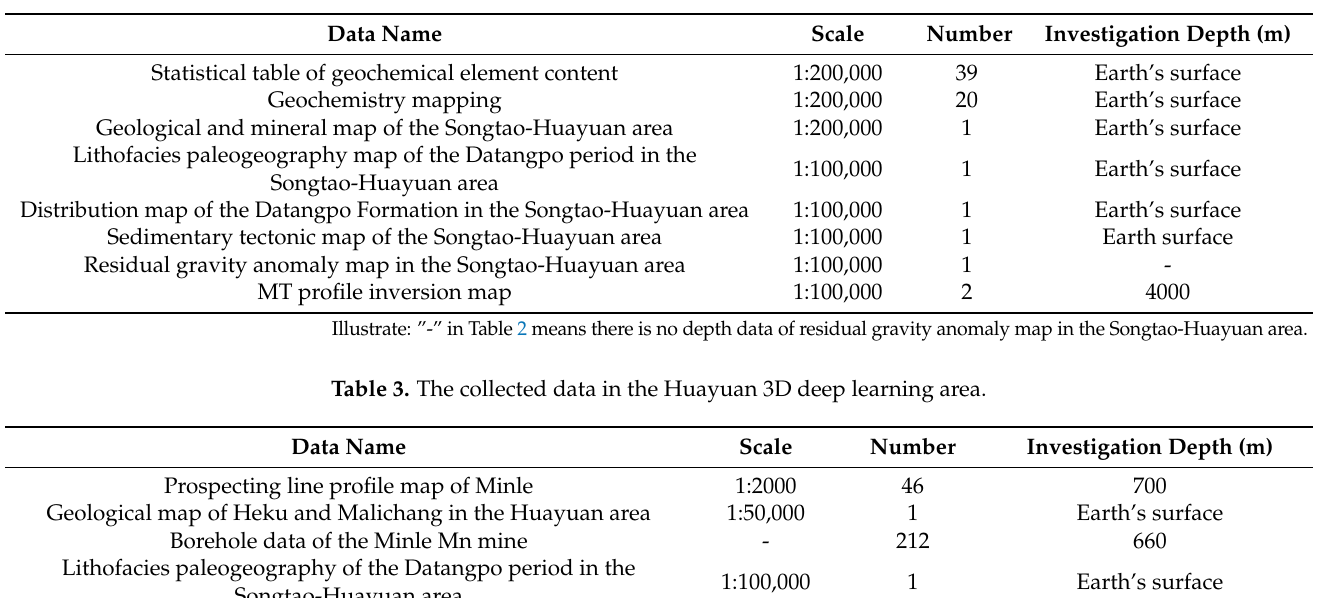
Table 2. The collected data in the Songtao-Huayuan 2D prediction area.